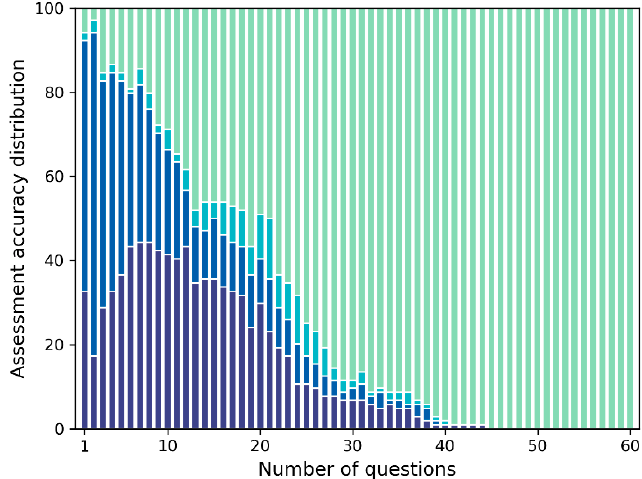
Figure 6. Distribution of assessment accuracies for students, where dark blue <1%, blue 1–50%, cyan 50–99%, and green >99% accuracy.